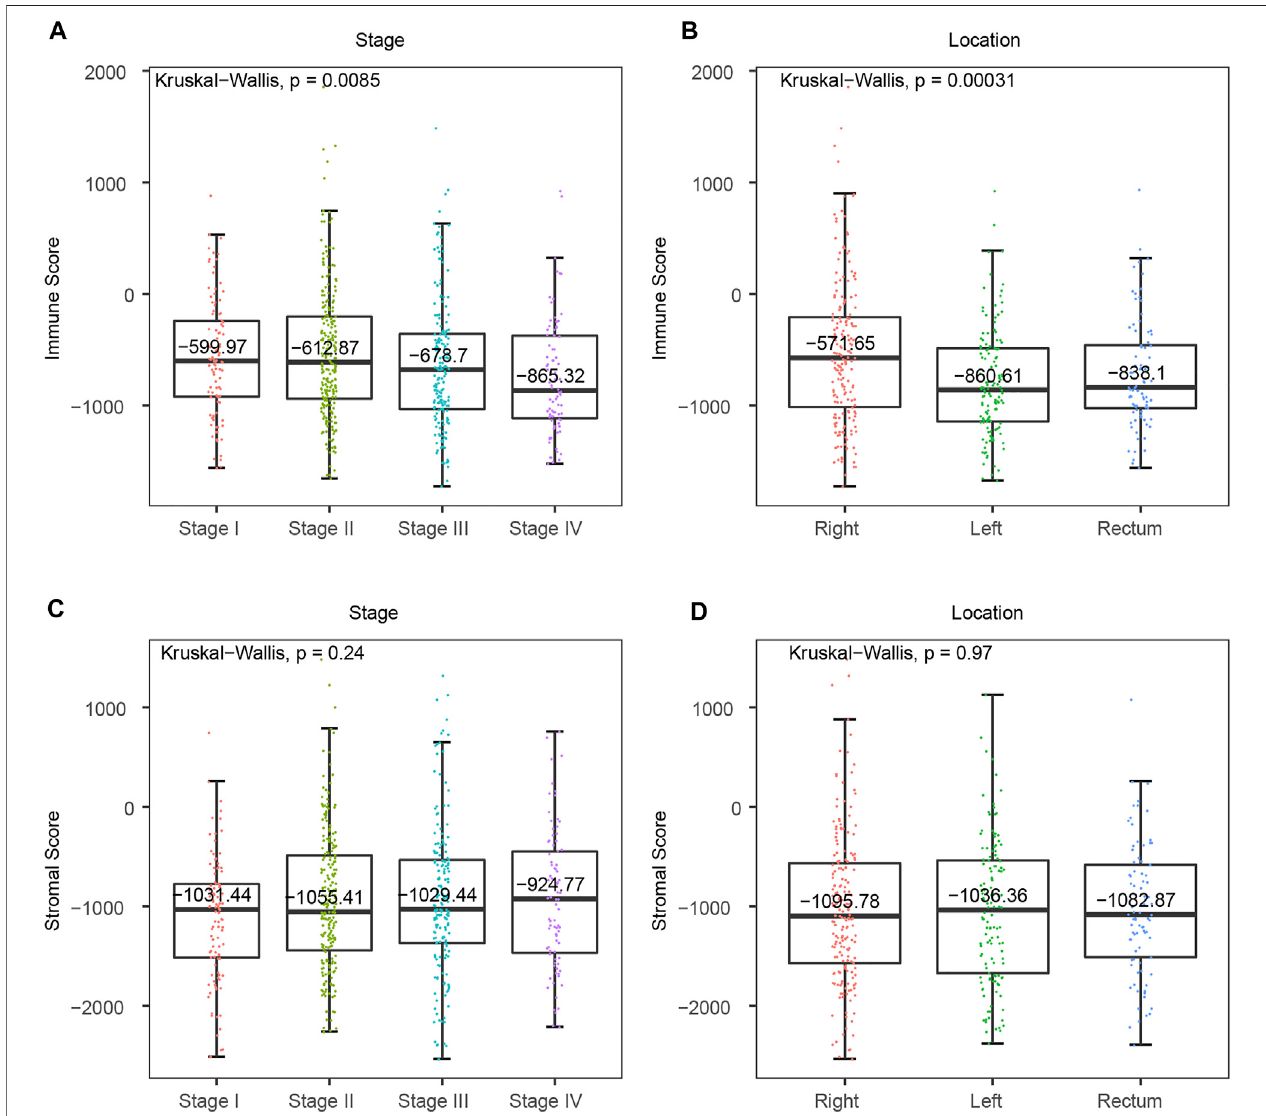
FIGURE2| AssociationbetweentumormicroenvironmentscoresandclinicalfeaturesinTCGACRCcohort. (A) DistributionofimmunescoresinconsecutiveCRC tumor stages. (B) Distribution of immune scores from distinct CRC primary tumor locations. (C) Distribution of stromal scores in consecutive CRC tumor stages. (D) Distribution of stromal scores from different CRC primary tumor